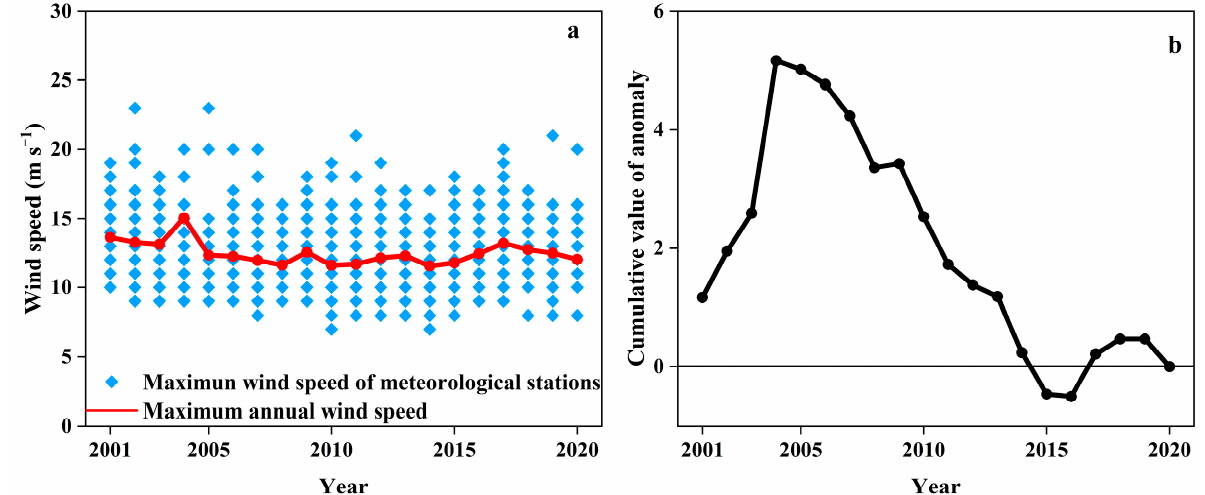
Figure 4. Interannual variation of the maximum annual wind speed and its cumulative value of anomaly in the water erosion area of the typical black soil region from 2001 to 2020. (( a ): maximumu annual wind speed, ( b ):cumulative anomalous values of maximum annual wind speed).